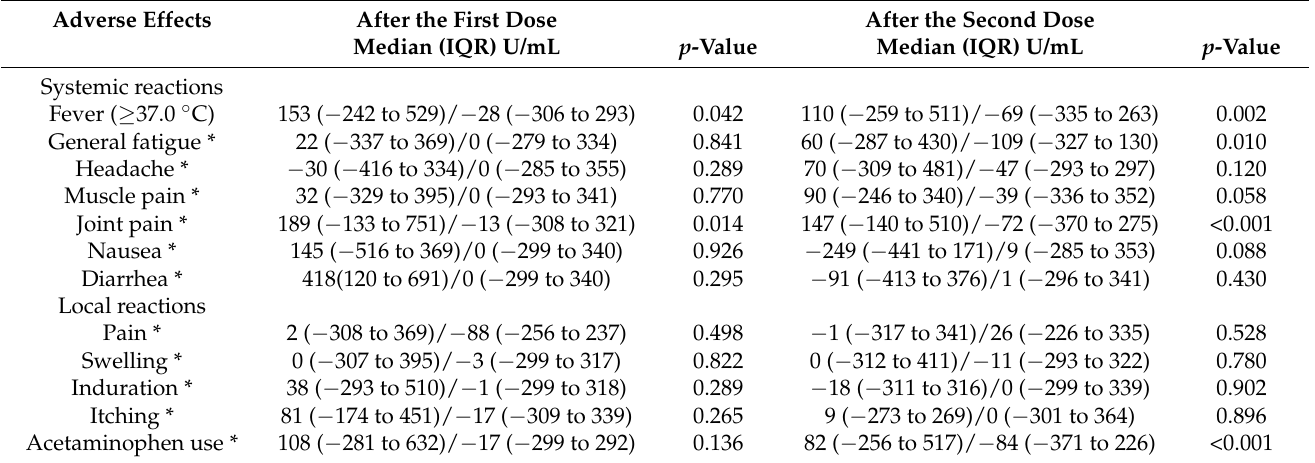
Table 3. Relationship between adverse effects and age-adjusted antibody titers at 3 months after vaccination ( n = 378).